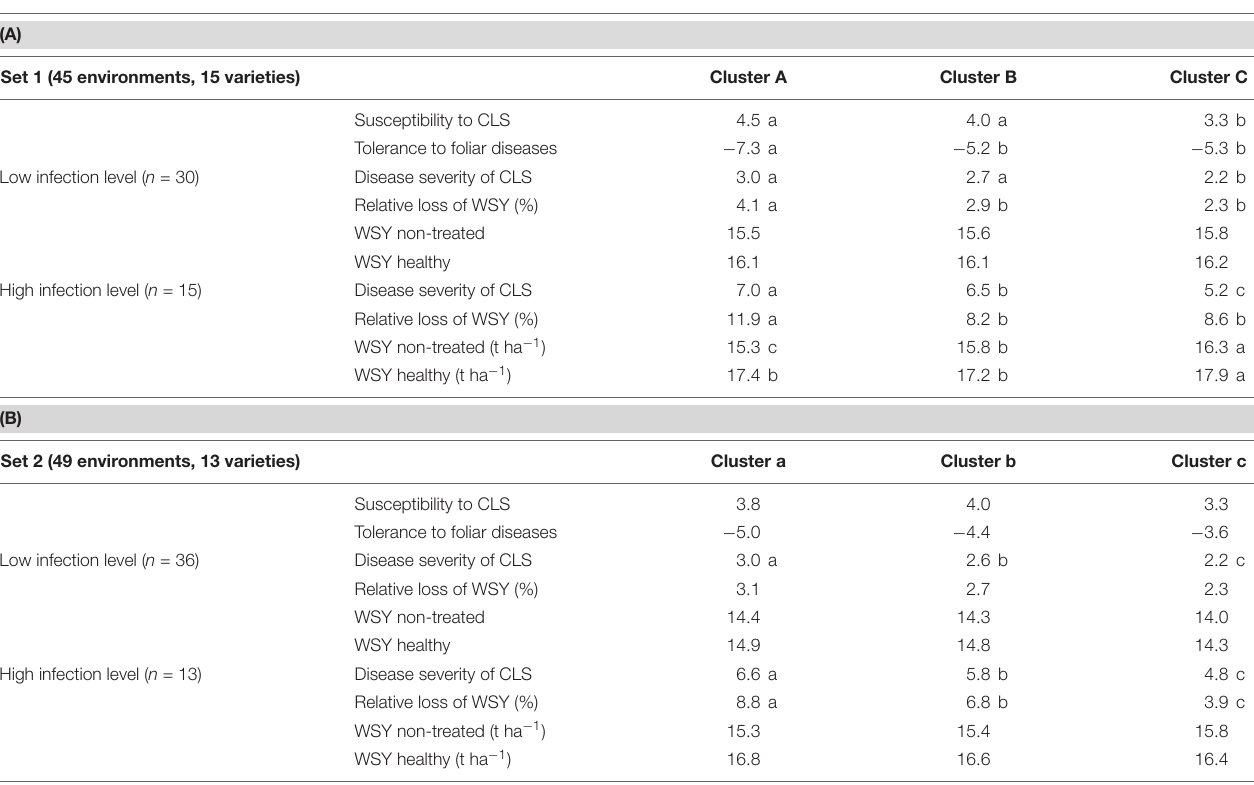
TABLE 6 | Different traits of three clusters (for details see Figure 5 ) of sugar beet varieties tested at (A) 45 environments in Germany, 2014–2016 and (B) 49 environments in Germany,